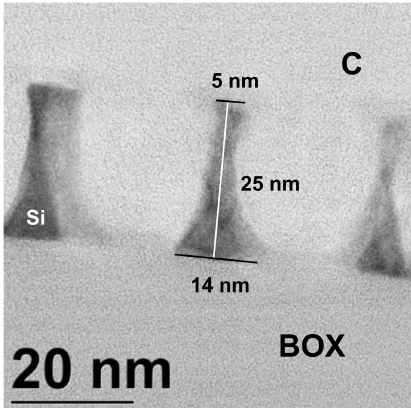
Figure 7. TEM micrograph of a lamella across several transferred SiNWs (before release). C serves as protective layer. SiNW height is determined by the thickness of the device layer of the SOI